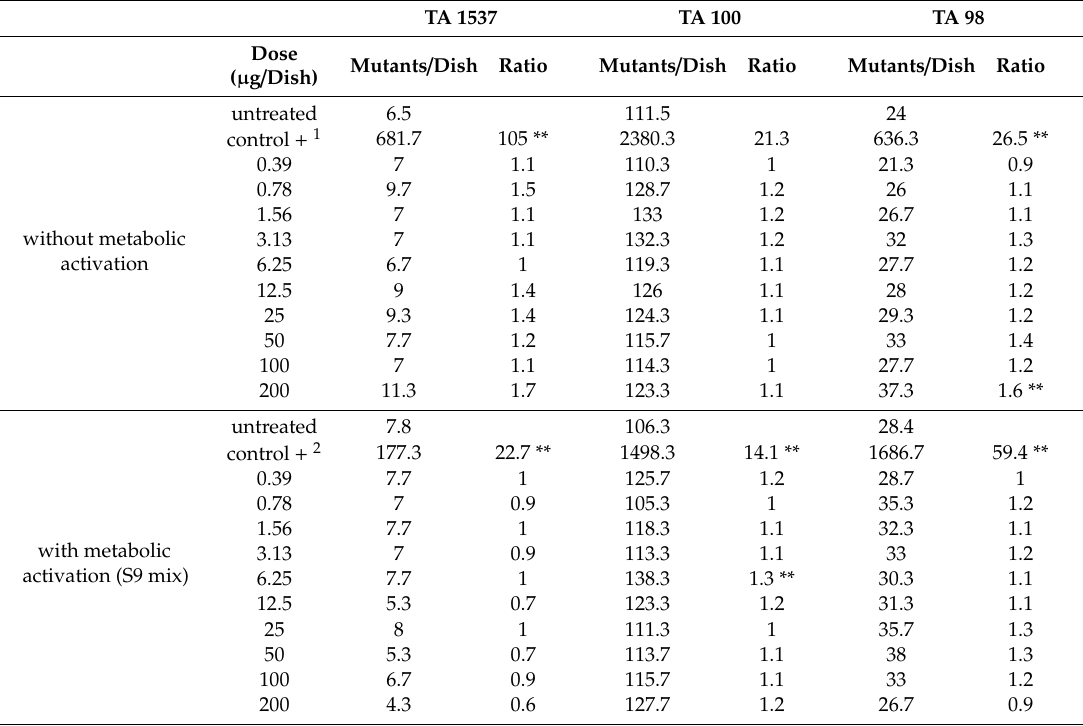
Table 1. Results of the BN Ames’